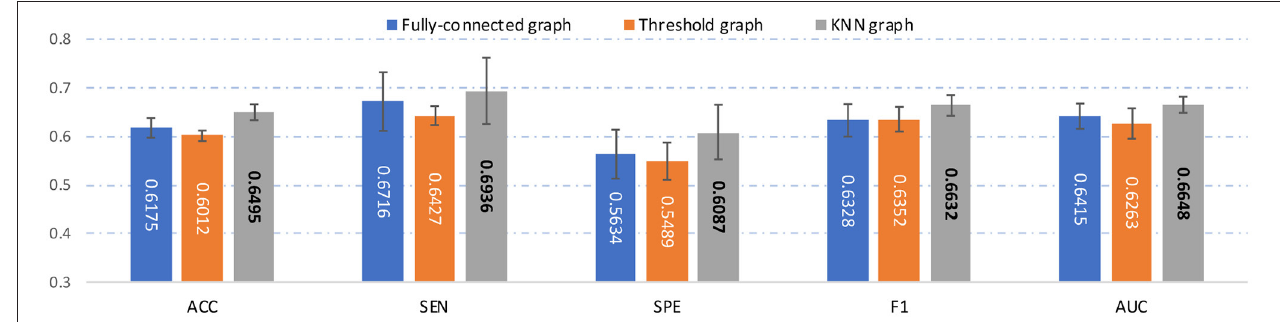
FIGURE 6 | Results of the proposed AMNI based on three different graph construction methods (e.g.fully-connected graph, threshold graph, and KNN graph) in the task of MDD vs. HC classification, with best results shown in bold.